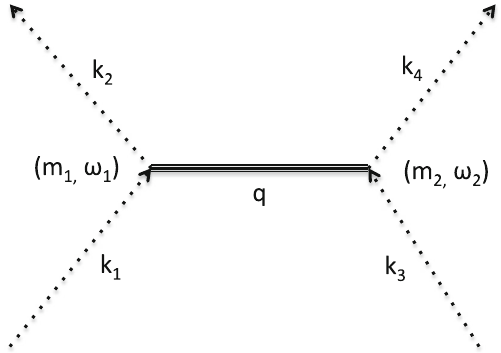
Fig. 1 The tree diagram contributes to the scalar-modified Newtonian potential. The graviton-graviton scattering yields the Newtonian poten- tial,whilethegravitationalscalarinteractionresultsfromtheexchanges of scalar particles, which accompanies the graviton exchanges. The triple solid lines represent the exchanges of gravitons and accompanied exchanges of scalar particles in a scalarized binary system, in which the central thick line denotes the gravitons, and the thin lines on two sides are the scalar particles.The dash lines are the scalar fields